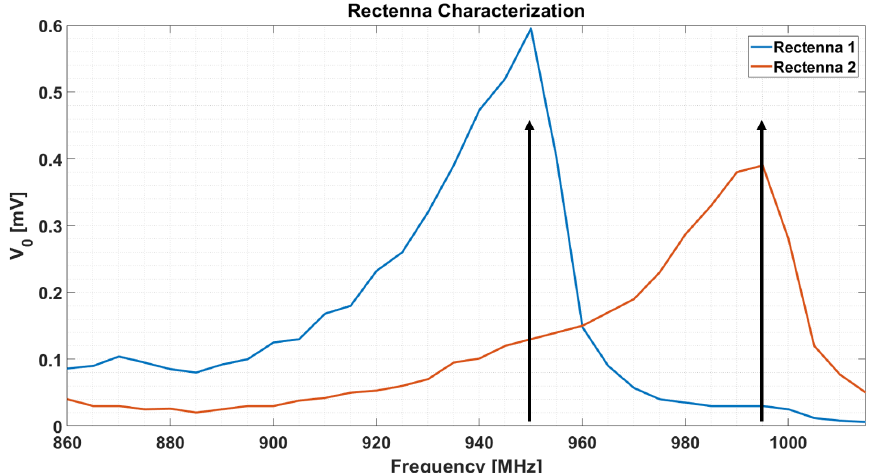
Figure 9. Frequency characterization of the implemented rectennas; this figure illustrates the maximum no-load voltage V O . The black arrows allude to the transmitted